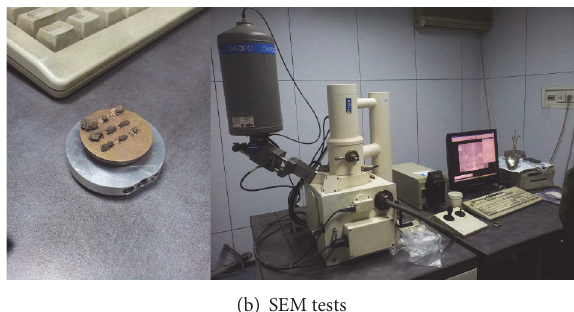
Figure 4: Sample preparation tools and SEM